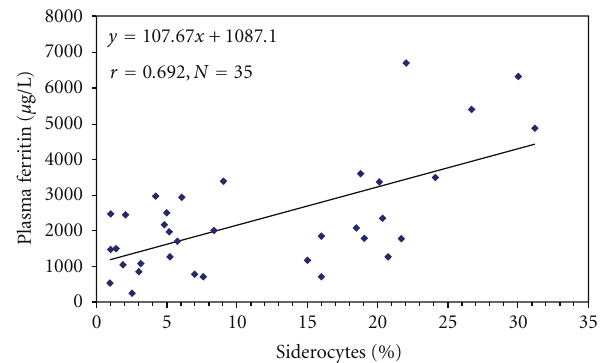
Figure 1: Relationship between plasma ferritin levels and percent siderocyte in splenectomized β -thalassemia/HbE patients. (A thin blood film was made, fixed in absolute methanol, and stained with Prussian blue staining. Siderocytes were counted per 1,000 red blood cells under light microscope connected to a digital camera and computer monitor. Plasma ferritin was measured using an immunoturbidimetric assay.)